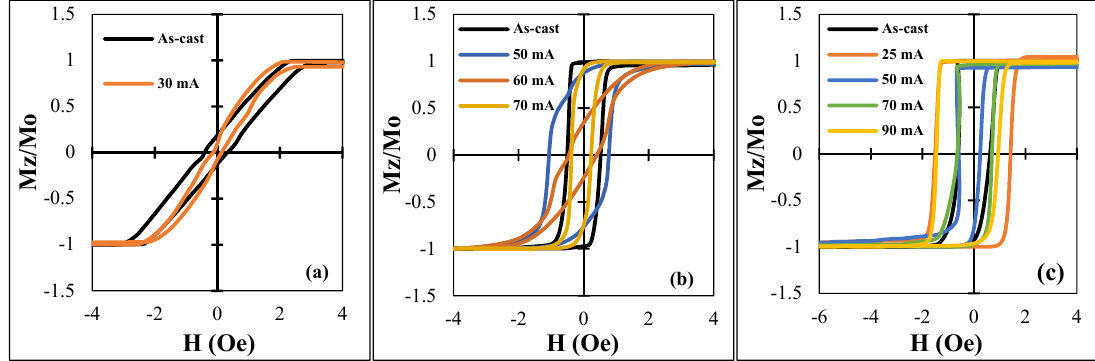
Figure 7. Hysteresis loops for all the samples after DC current annealing with different I an for 30 min: ( a ) − 1, ( b ) − 2, and ( c ) − 3.